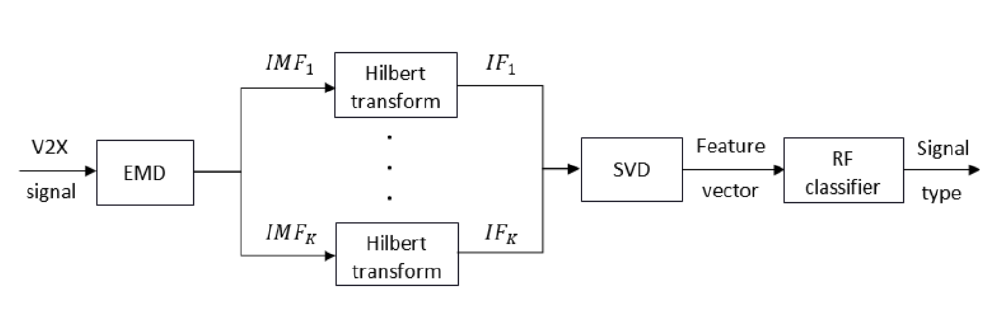
Figure 1. Pipeline of the proposed signal identification